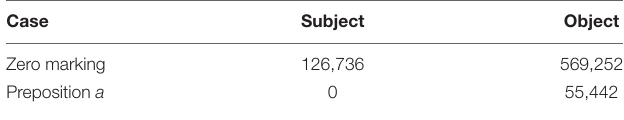
TABLE 3 | Frequencies of case forms in Hindi.